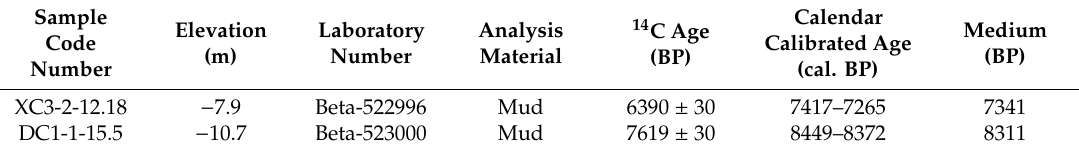
Table 1. 14 C data and calibrations of ancient beach sediments of Xichong and Dongchong.